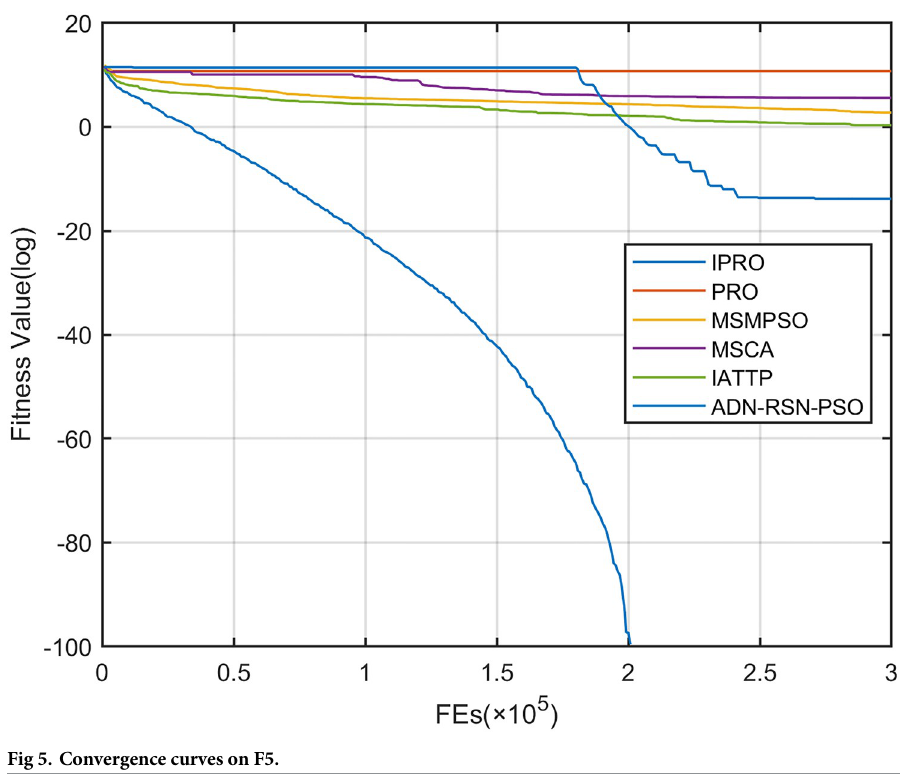
Fig 5. Convergence curves on F5.